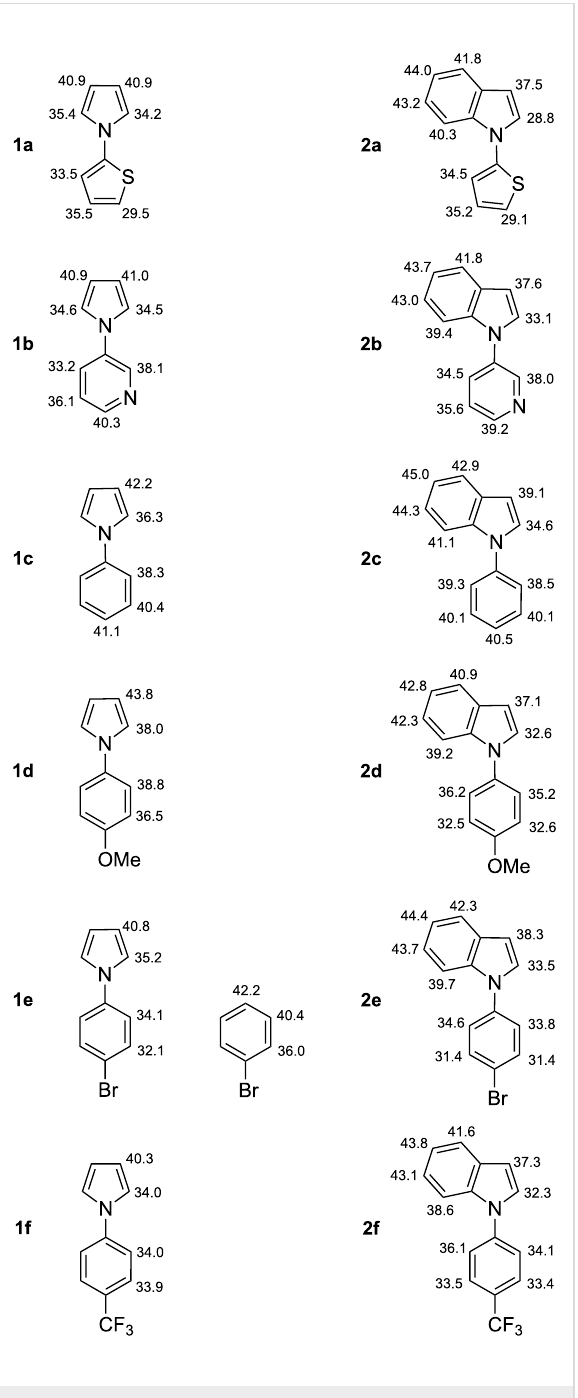
assignment of potential deprotonation sites in the investigated substrates. Also the correlation between gas-phase Δ G acid and the p K a (THF) values can be tracked. In all cases, the CH acidity increases when changing from electron-donating groups to more electron-withdrawing ones. One can easily see that